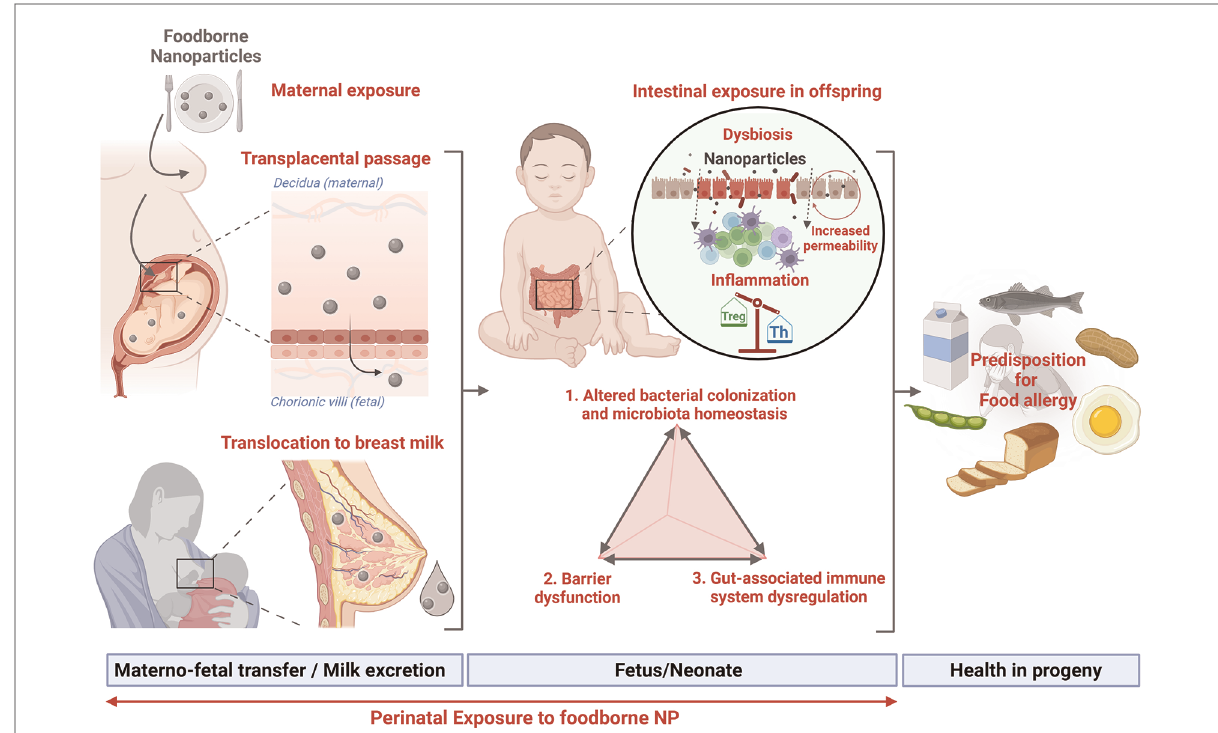
FIGURE 4 Perinatal exposure to nanoparticles and susceptibility to food allergy (created with